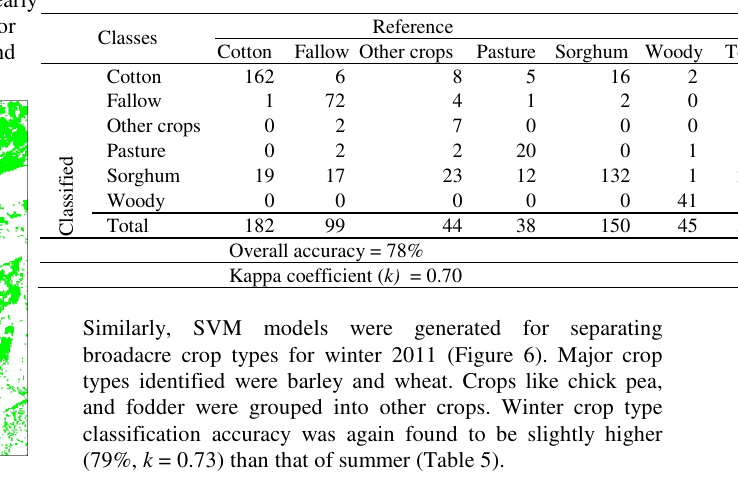
Table 5. Accuracy assessment of winter 2011 classification